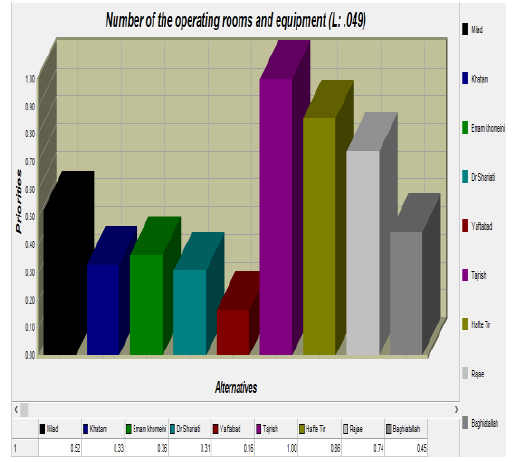
Figure 10. Ranking hospitals in terms of index G. Figure 11. Ranking hospitals in terms of index